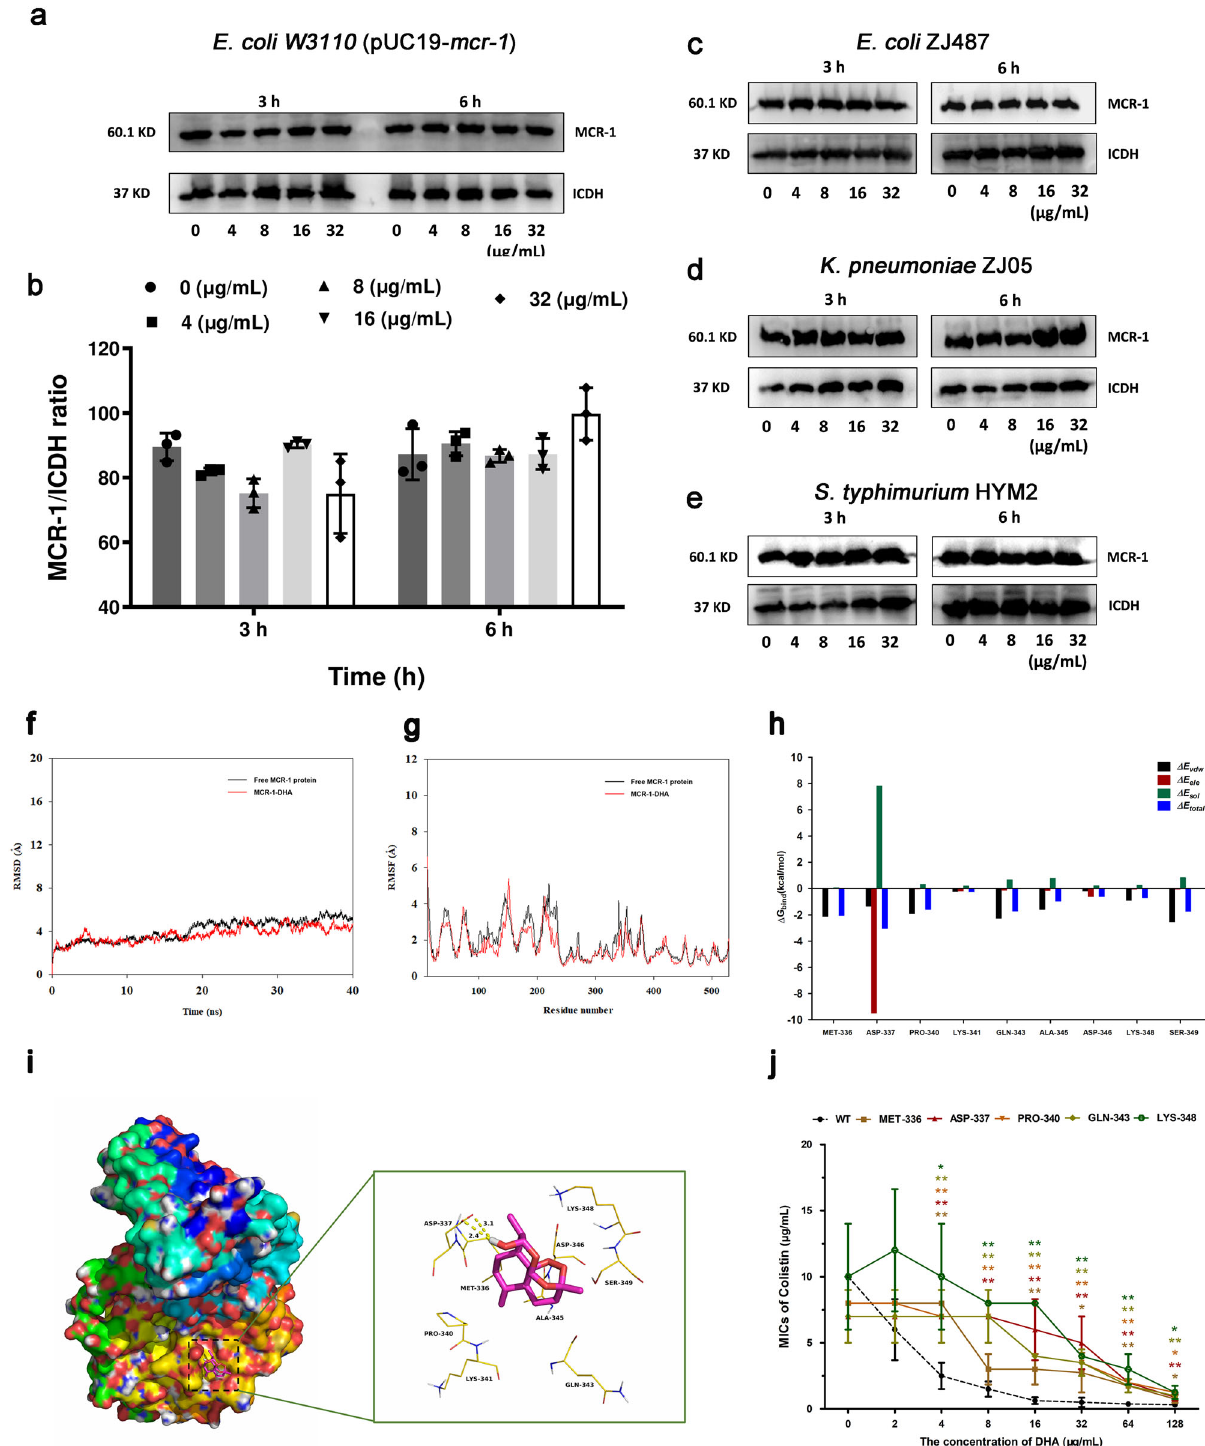
Fig. 6 Direct engagement by DHA resulted in the inhibition of MCR-1 activity. a – e MCR-1 production in E. coli W3110 (pUC19- mcr-1 ) ( a , b ), E. coli ZJ487 ( c ), K. pneumoniae ZJ05 ( d ) and S. typhimurium HYM2 ( e ) cocultured with the indicated DHA treatment was determined by western blotting assays. f The root-mean-square deviations (RMSDs) of all the atoms of MCR-1-DHA complex with respect to its initial structure as a function of time. g RMSF of residues of the whole protein in the MCR-1-DHA complex and free MCR-1 during the 40 ns simulation. h Decomposition of the binding energy on a per- residue basis in the MCR-1-dihydroartemisinin complex. i The predicted binding mode of DHA in the MCR-1 binding pocket obtained from MD simulation. j The synergistic activity of DHA (at concentrations ≥ 4 µ g/mL) with colistin for the bacteria harboring MCR-1 mutants was signi fi cantly decreased compared with E. coli W3110 (pUC19- mcr-1 ) ( n = 4). * P < 0.05. ** P <